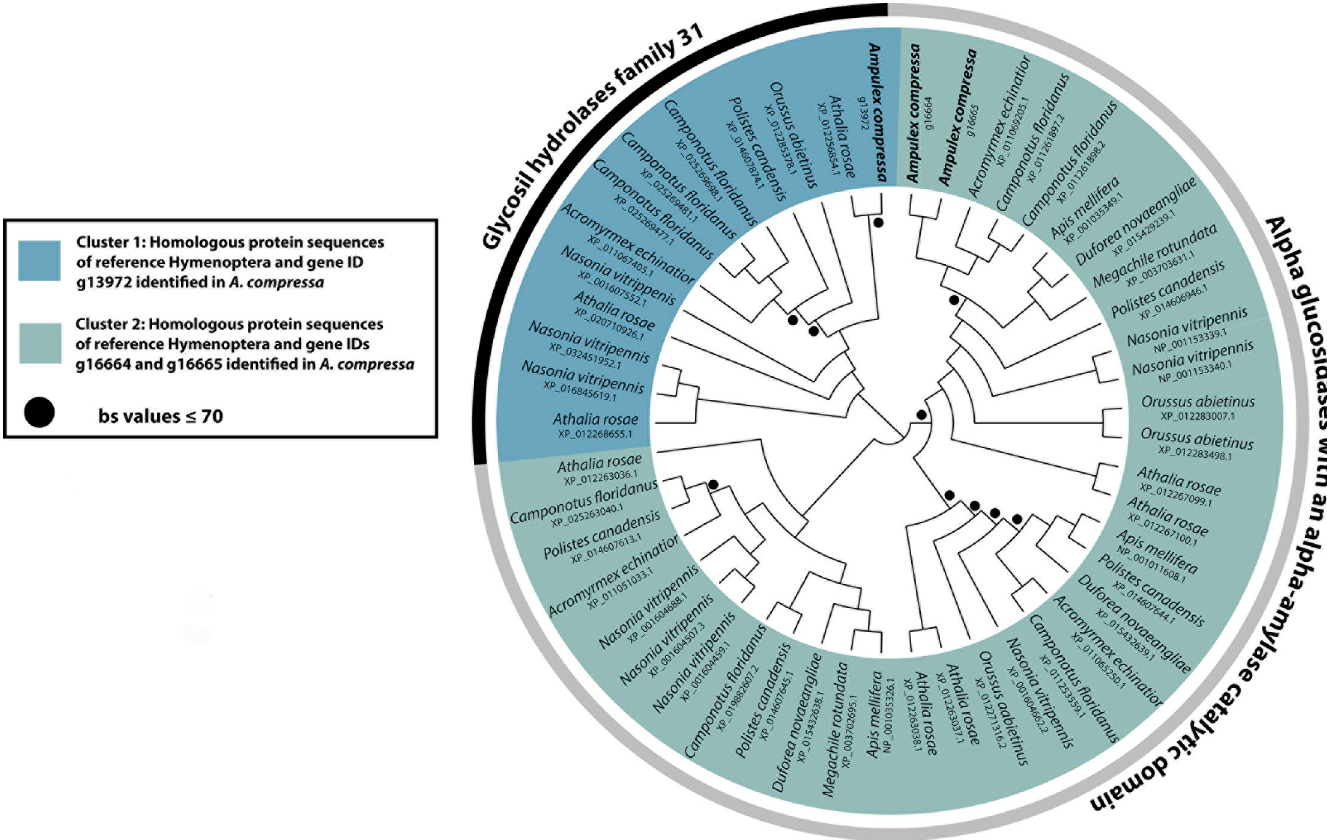
Fig 5. Unrooted maximum likelihood tree of candidate alpha-glucosidase protein sequences identified in the midgut transcriptome of A . compressa and nine reference Hymenoptera species. The two main groups recovered are labeled in the tree. One comprises glycosyl hydrolase family 31 and the other all alpha-glucosidase gene sequences that are characterized with an alpha-amylase catalytic domain. Black dots indicate bootstrap support values � 70. All protein sequences of A . compressa are available as Supplementary data at Dryad Repository. Accession numbers and information on the reference taxa are provided in the S7 Table.